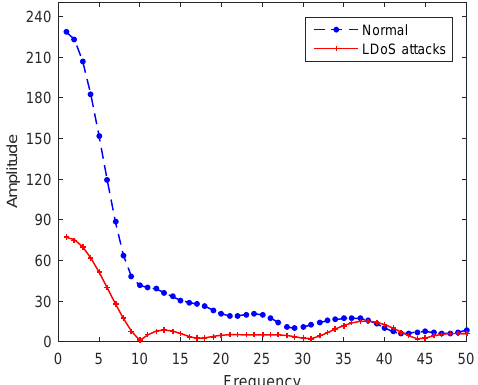
Figure 5. Instantaneous frequency